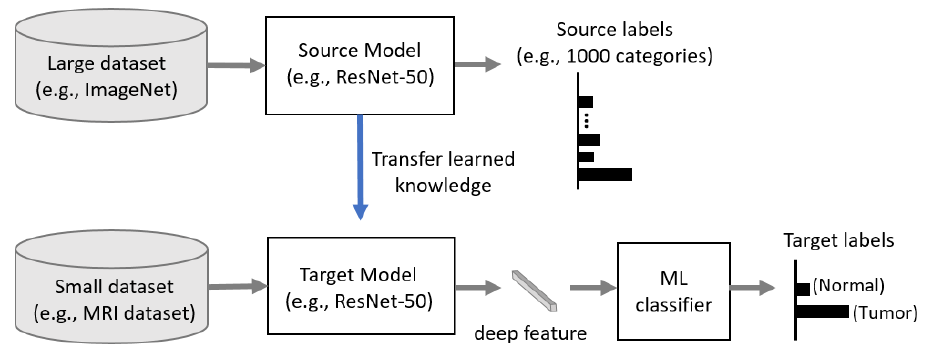
Figure 4. Concept of transfer